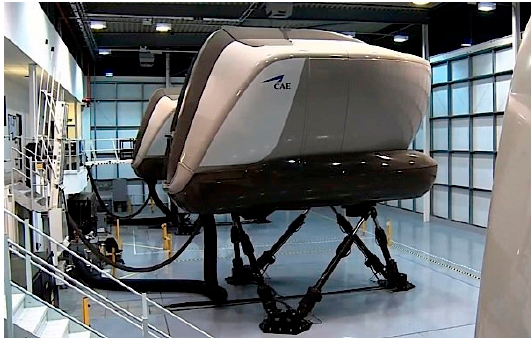
Figure 5. Integrated CAE 7000XR flight simulator [12].